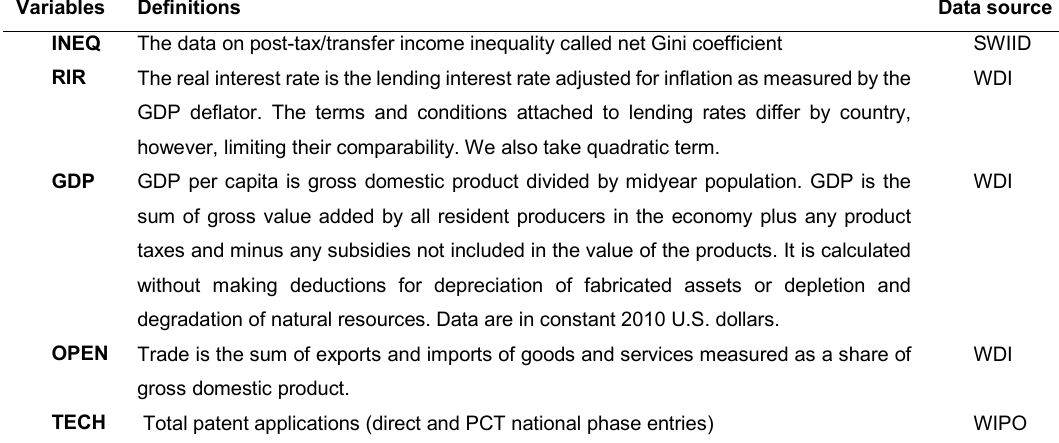
Table1. Definition of data and their